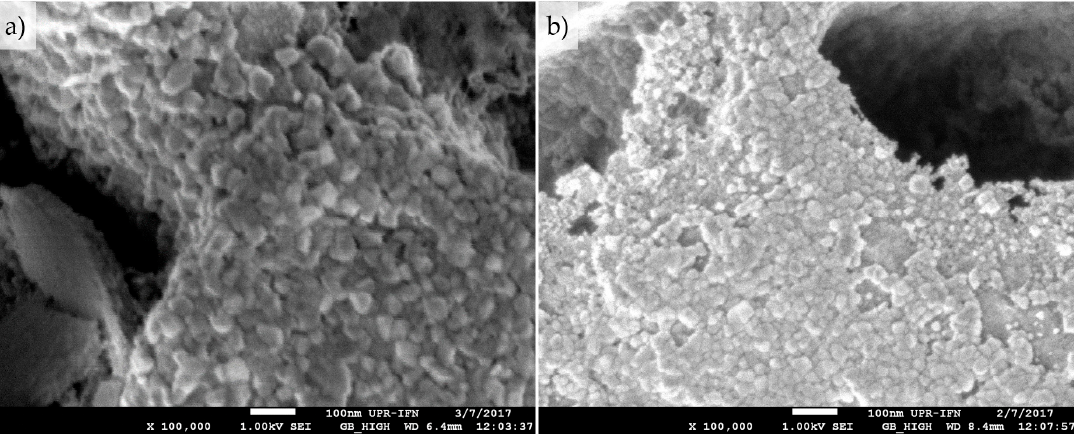
Figure 8. Surface of: ( a ) HC-2 and ( b ) EC samples after corrosion.